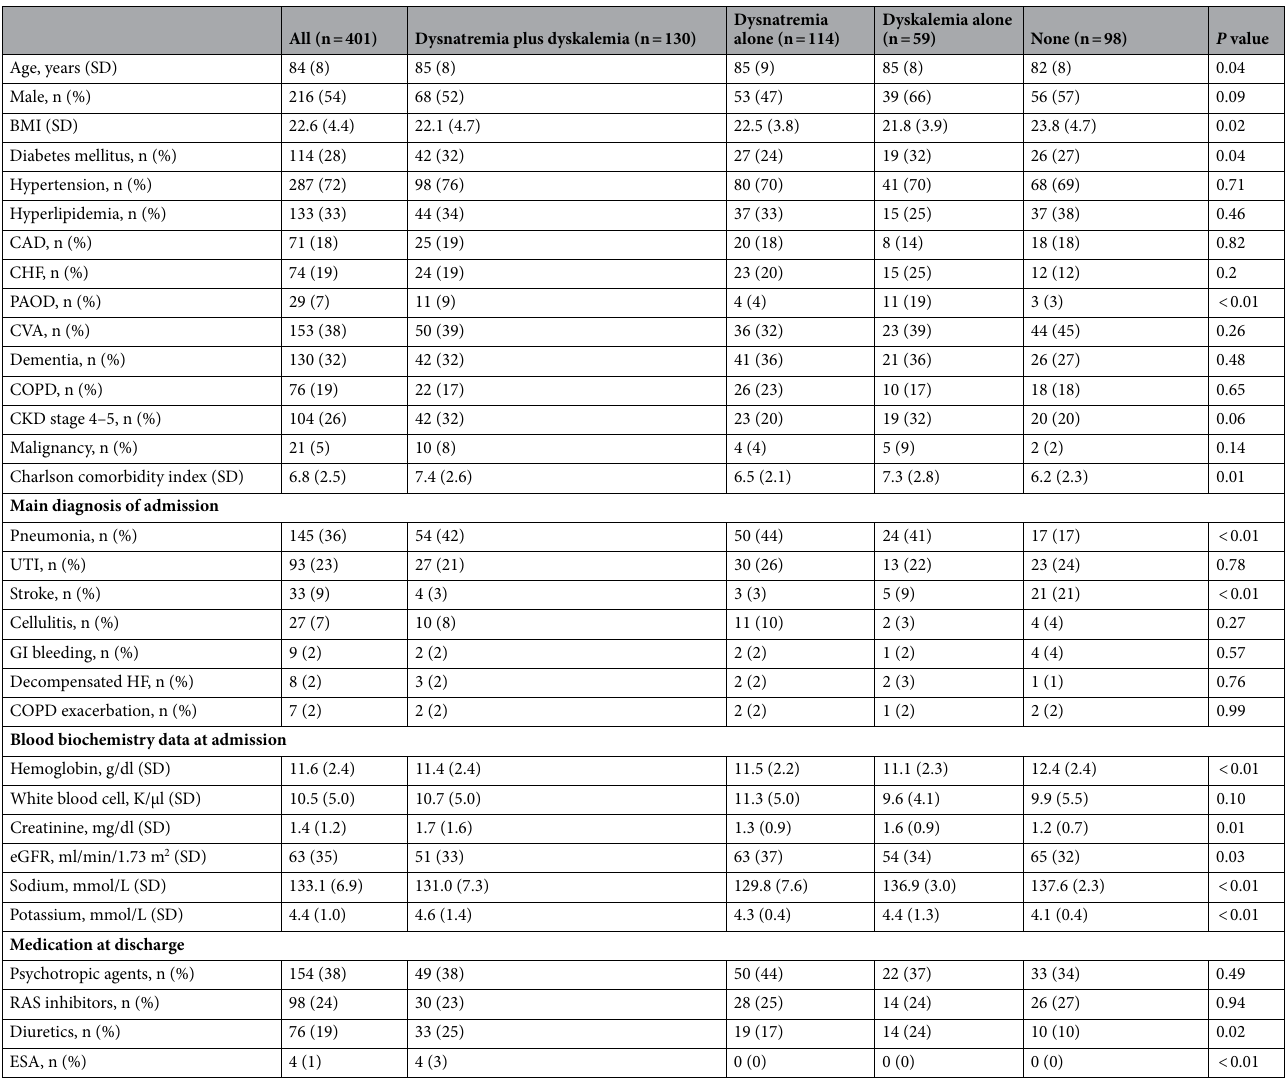
Table 1. Baseline characteristics of the study population with or without dysnatremia and dyskalemia. SD standard deviation, BMI body mass index, CAD coronary artery disease, CHF congestive heart